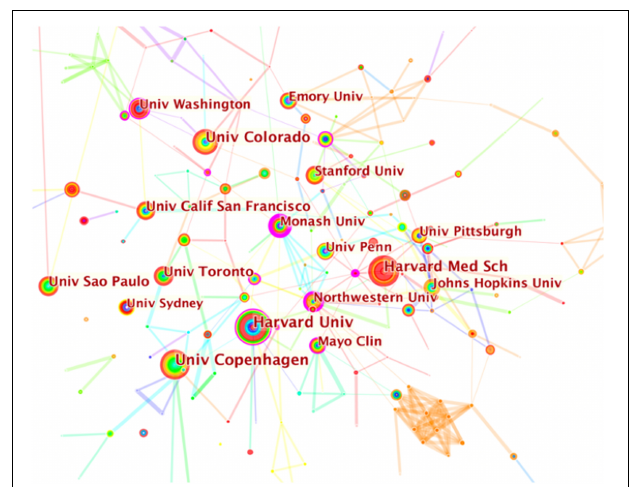
FIGURE 3 | Network map of institutions contributed to physical activity therapy for diabetes research. Each colored solid circle represents a country/region, and the lines between them represent collaborative relationships.